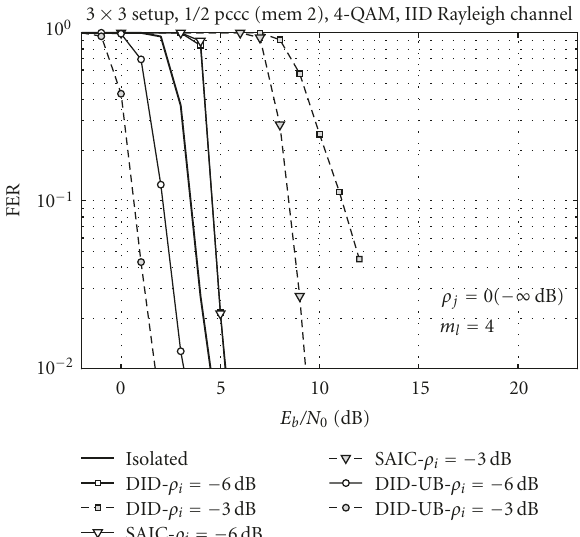
Figure 7: FER curves for di ff erent receive strategies in decentralized detection: distributed iterative detection (DID), SAIC-aided DID (SAIC), DID with unconstrained backhaul